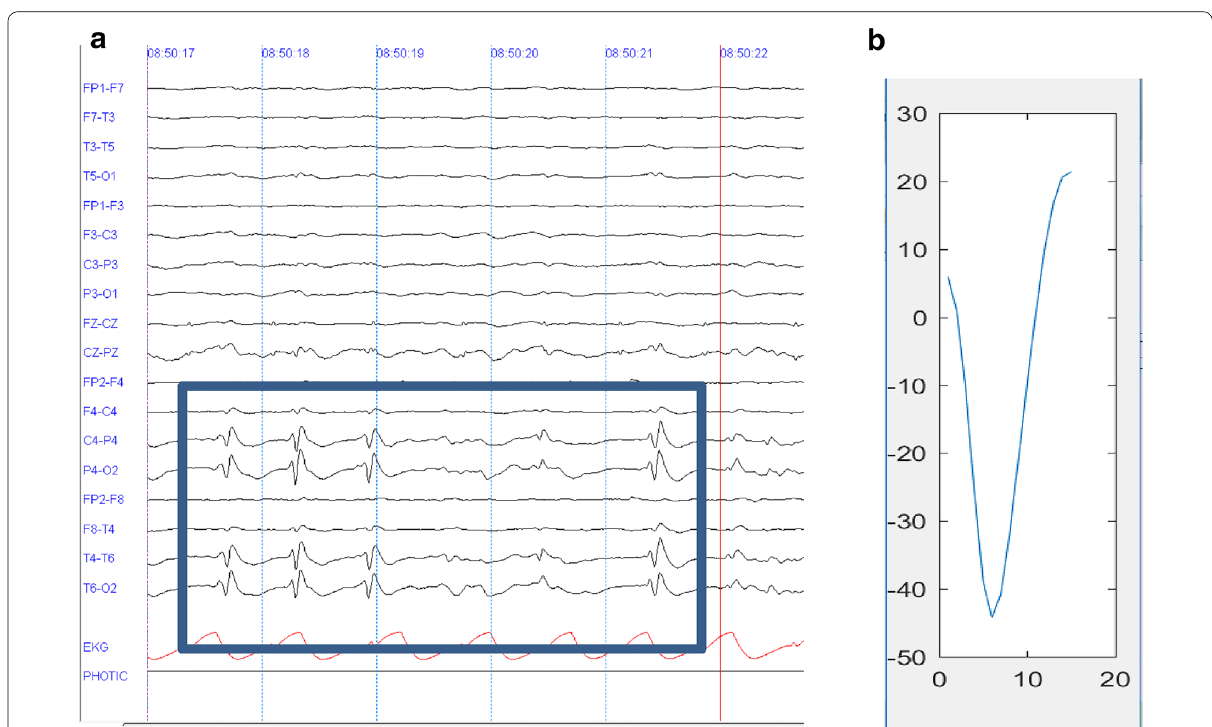
Fig. 2 Visual inspection of spikes. a Epileptic spikes in the base rhythm. b Epileptic spike